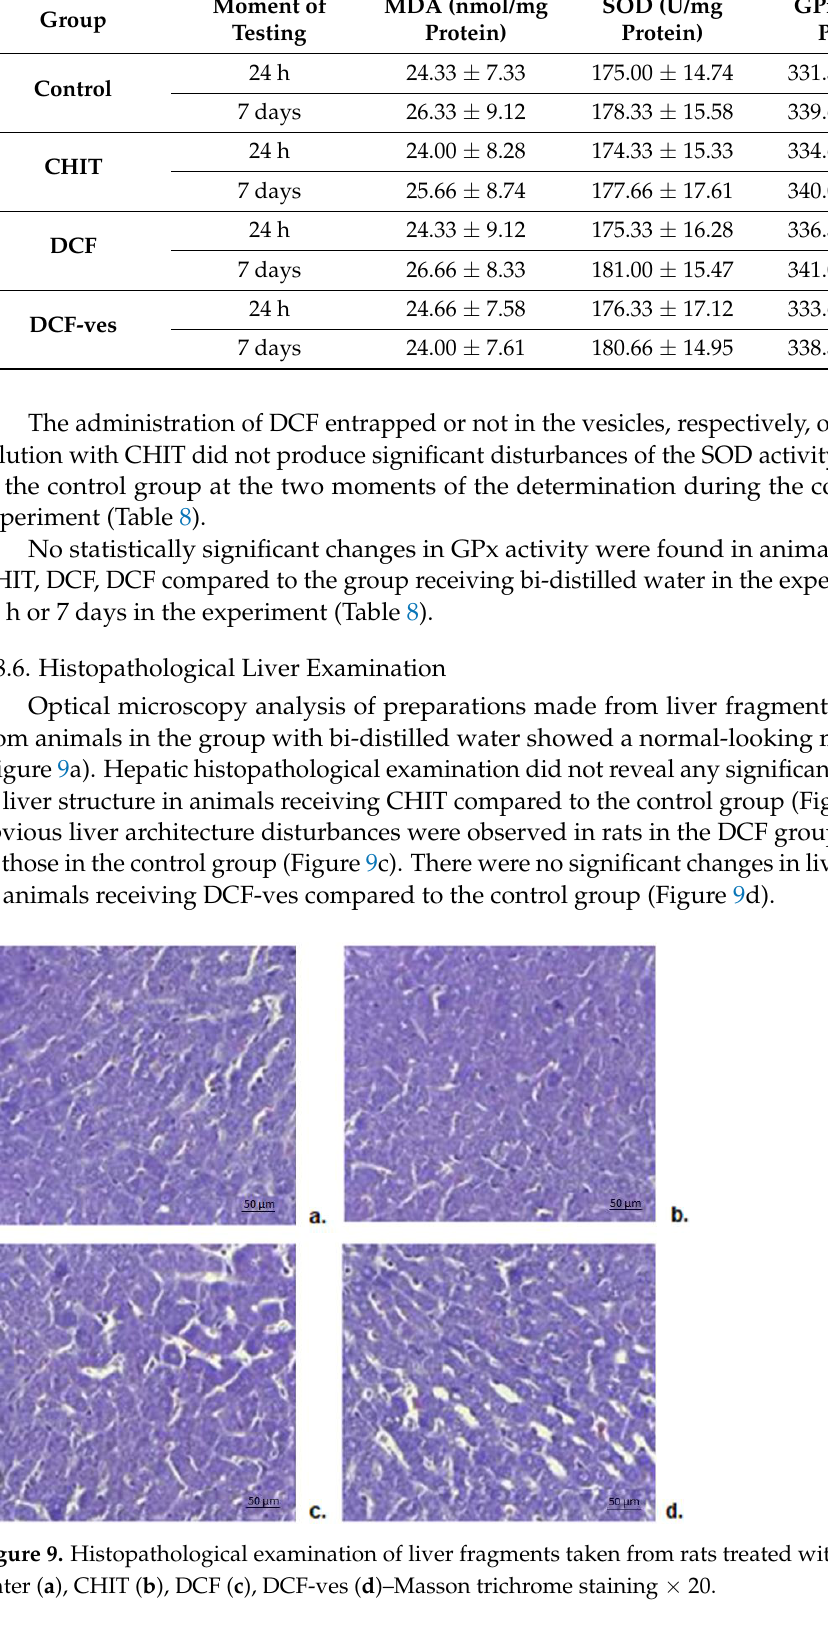
Figure 9. Histopathological examination of liver fragments taken from rats treated with bi-distilled water ( a ), CHIT ( b ), DCF ( c ), DCF-ves ( d ) – Masson trichrome staining x 20. water ( a ), CHIT ( b ), DCF ( c ), DCF-ves ( d )–Masson trichrome staining ×